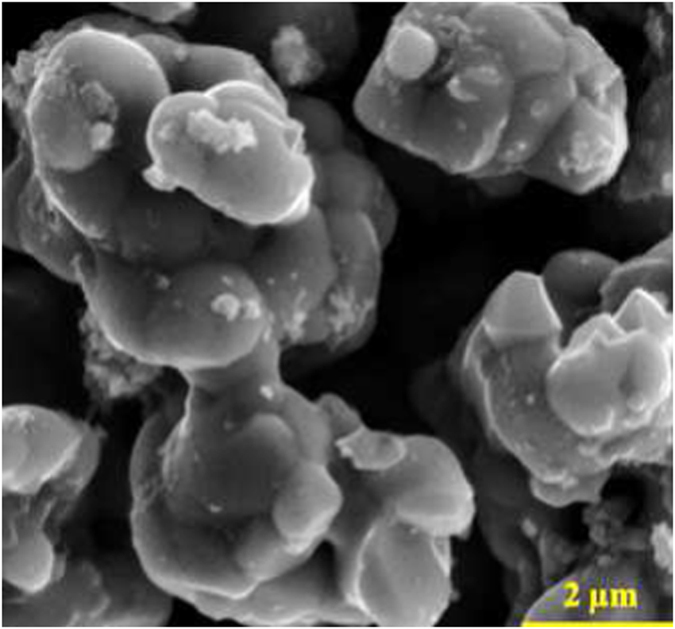
SEM image (secondary electron imaging mode) of Zr2(Al0.42Bi0.58)C powder (Zr2(Al0.41Bi0.59)C synthesis attempt at 1150 °C).